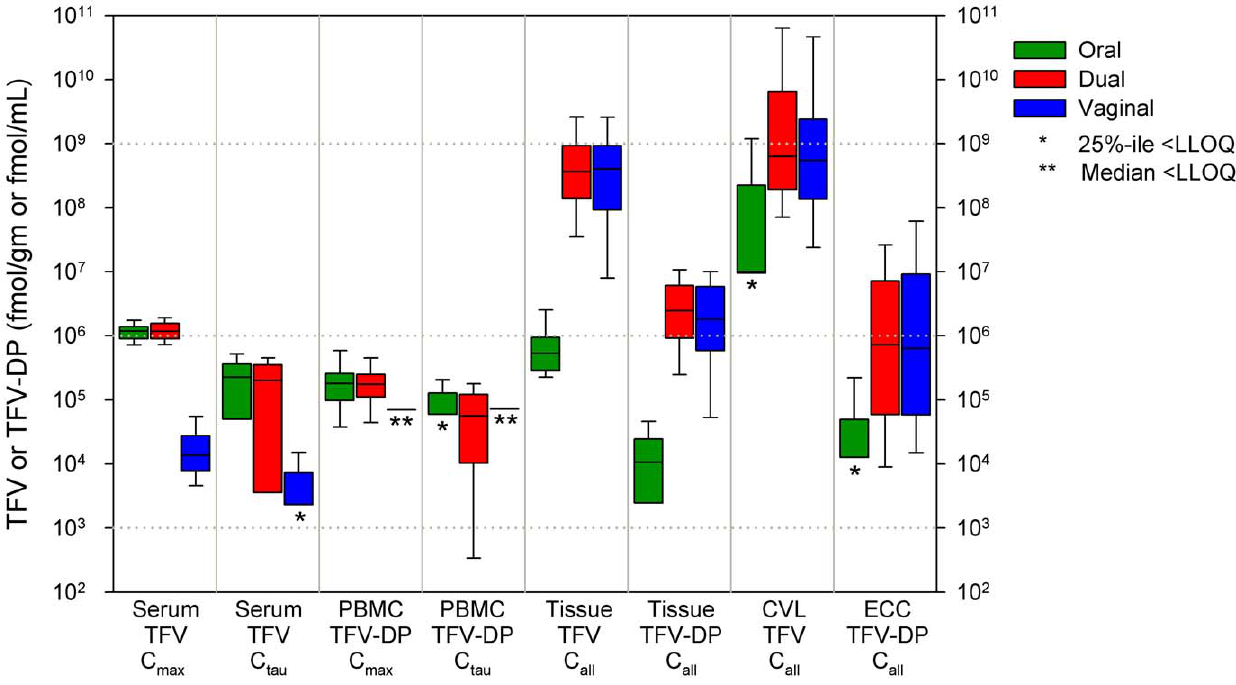
Figure 3. Boxplots of TFV and TFV-DP concentrations by anatomic site. Side-by-side boxplots of end-of-period visit data for all participants by anatomic site and dosing regimen are shown. Each box indicates the interquartile range with center bar as median and whiskers 1.5 times the quartile. *Lower quartile (LQ) is below the limit of quantitation (LOQ), only median and above are shown. **Median is below LOQ, so the median of values above the LOQ are shown as a single bar. X-axis key: anatomic location , PBMC peripheral blood mononuclear cells, CVL cervicovaginal lavage, ECC endocervical cytobrush; drug moiety , TFV tenofovir, TFV-DP tenofovir diphosphate; sample timing , C max peak concentration following dose at clinic visit, C pre-dose concentration prior to dose at clinic visit, C all pools values from all participants regardless of scheduled time relative to